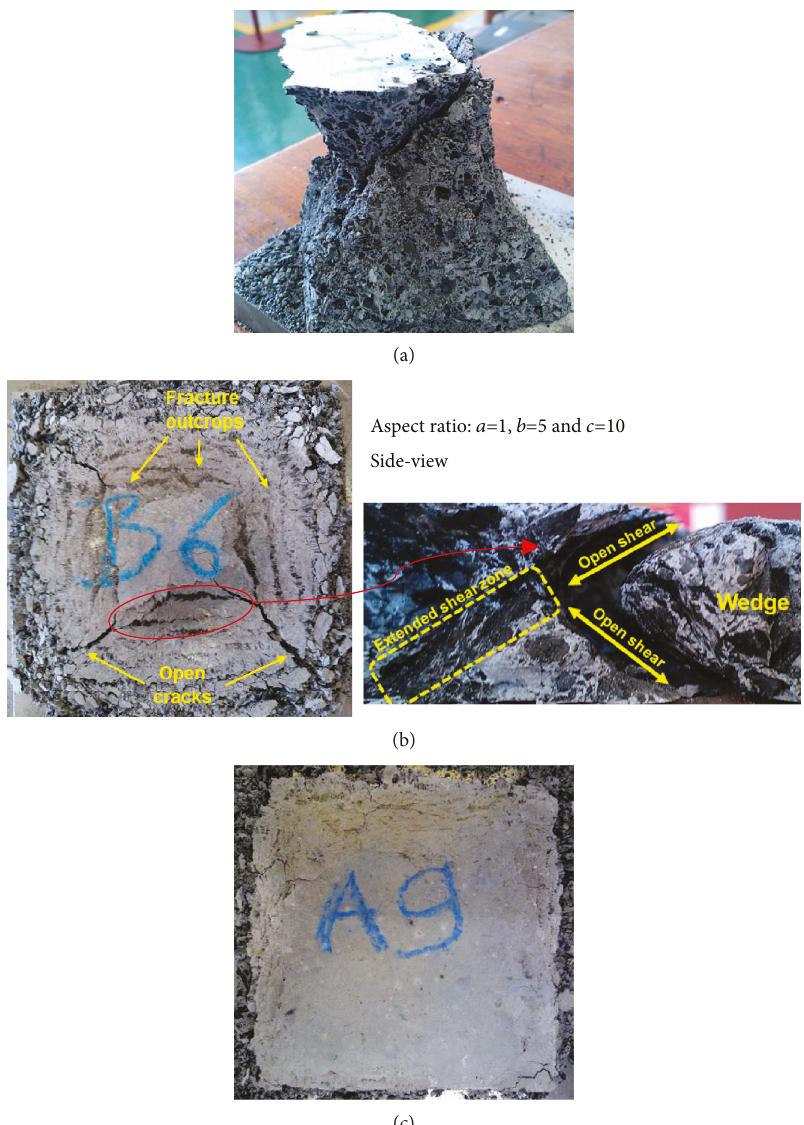
Figure 6: Fracture modes for specimens with di ff erent aspect ratio (modi fi ed from